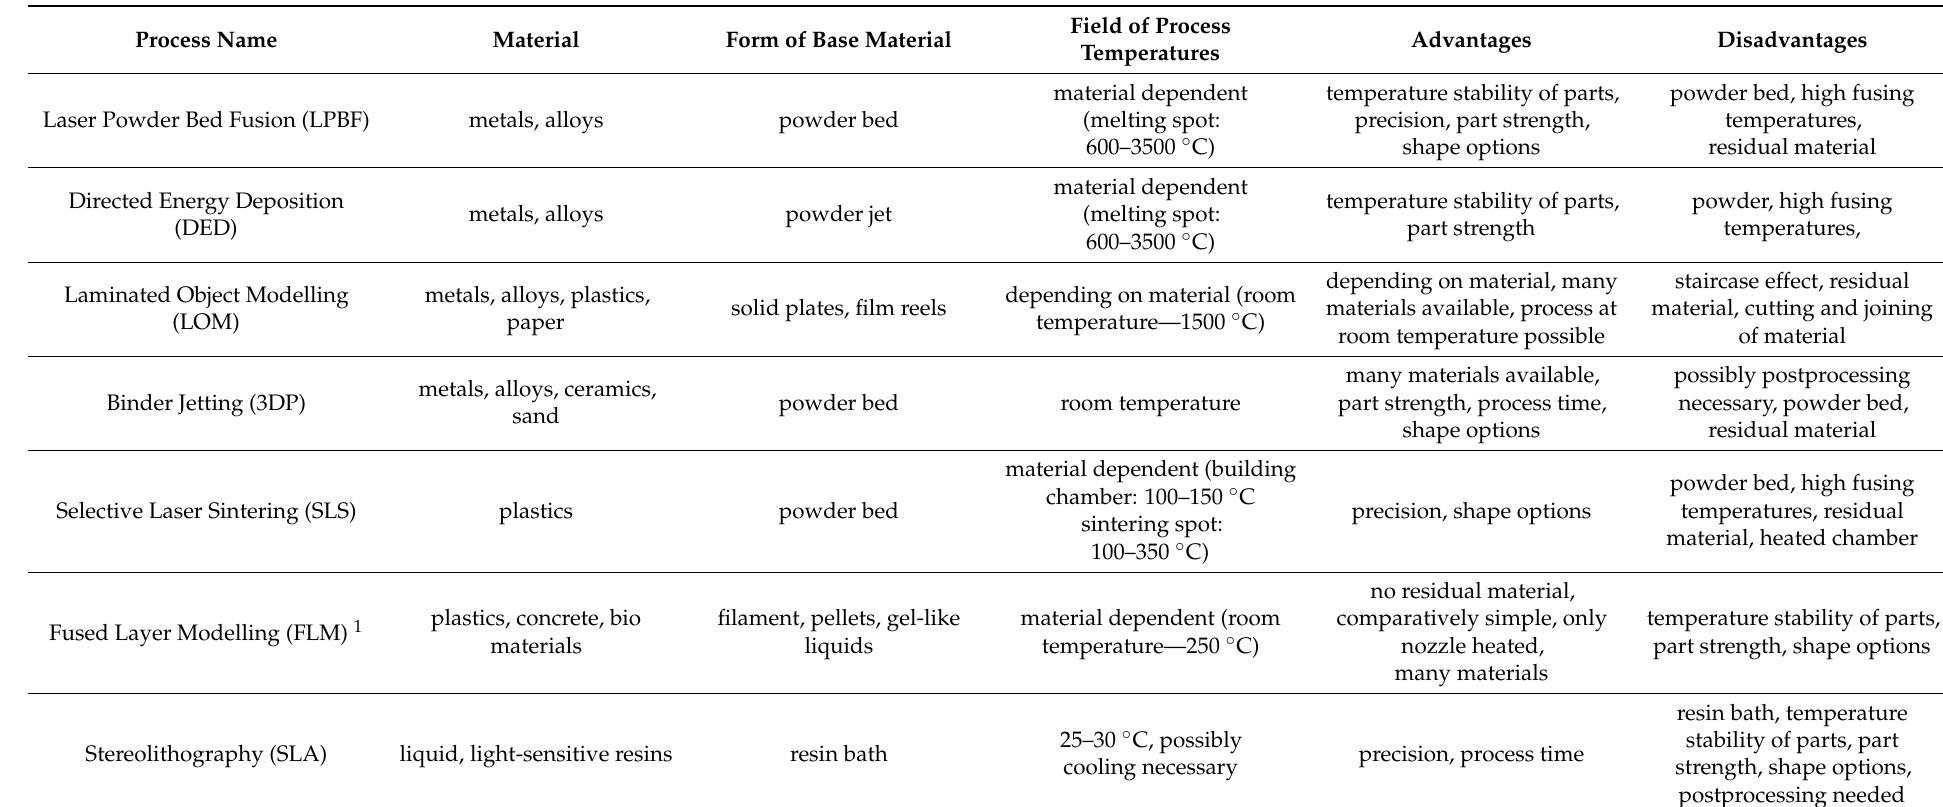
Table 2. Main characteristics of additive manufacturing processes in respect of the combination with vacuum assisted multipoint